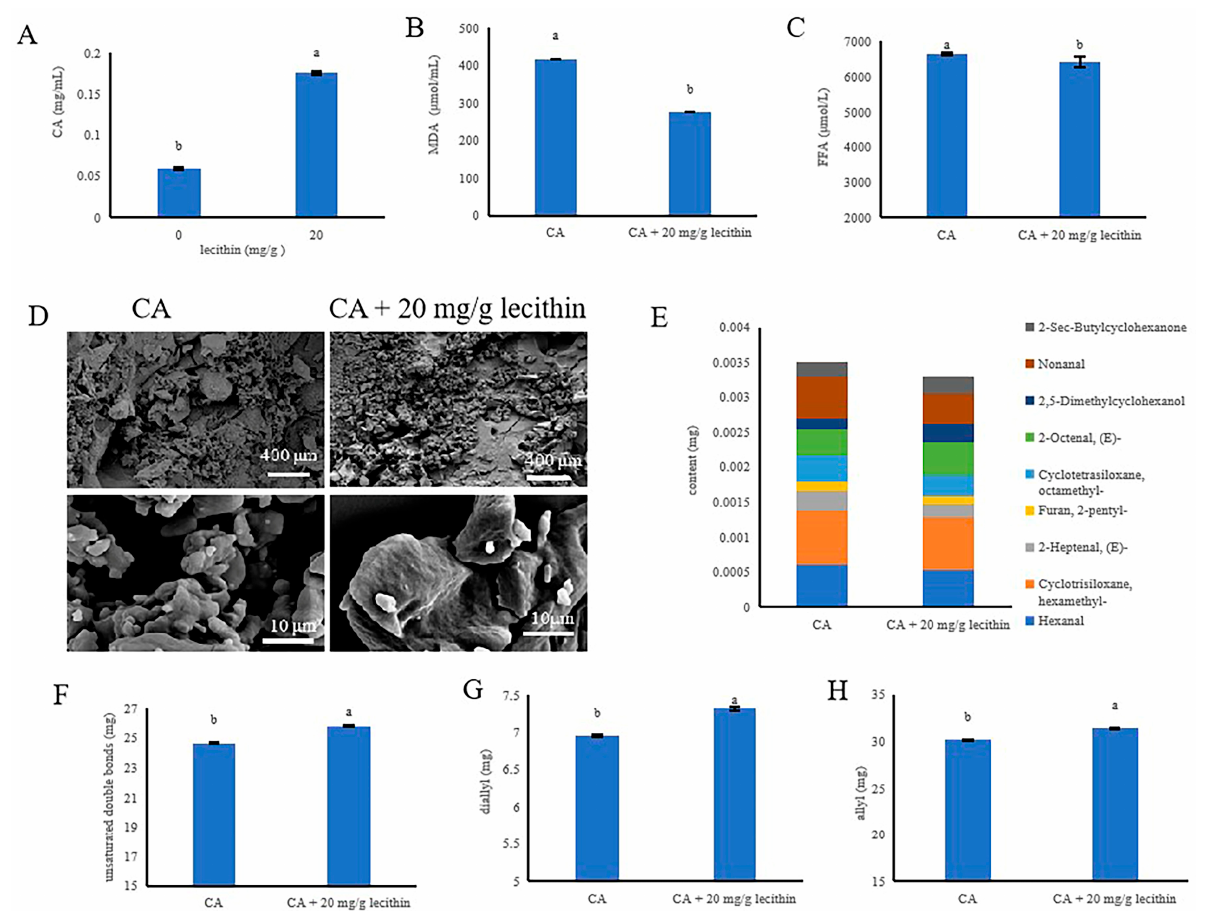
Figure 6. Improvement of the oxidative stability of Aoil by enrichment with lecithin-CA. Determination of the solubility of CA in Aoil ( A ). Determination of MDA ( B ) and FFA ( C ). Microstructure of Aoil enriched with CA and lecithin-CA ( D ). Volatile lipid oxidation product analyses of Aoil enriched with CA and lecithin-CA ( E ). Quanti fi cation of unsaturated double bonds ( F ), diallyl ( G ), and allyl ( H ). a-b means with di ff erent superscripts di ff er signi fi cantly ( p < 0.05).